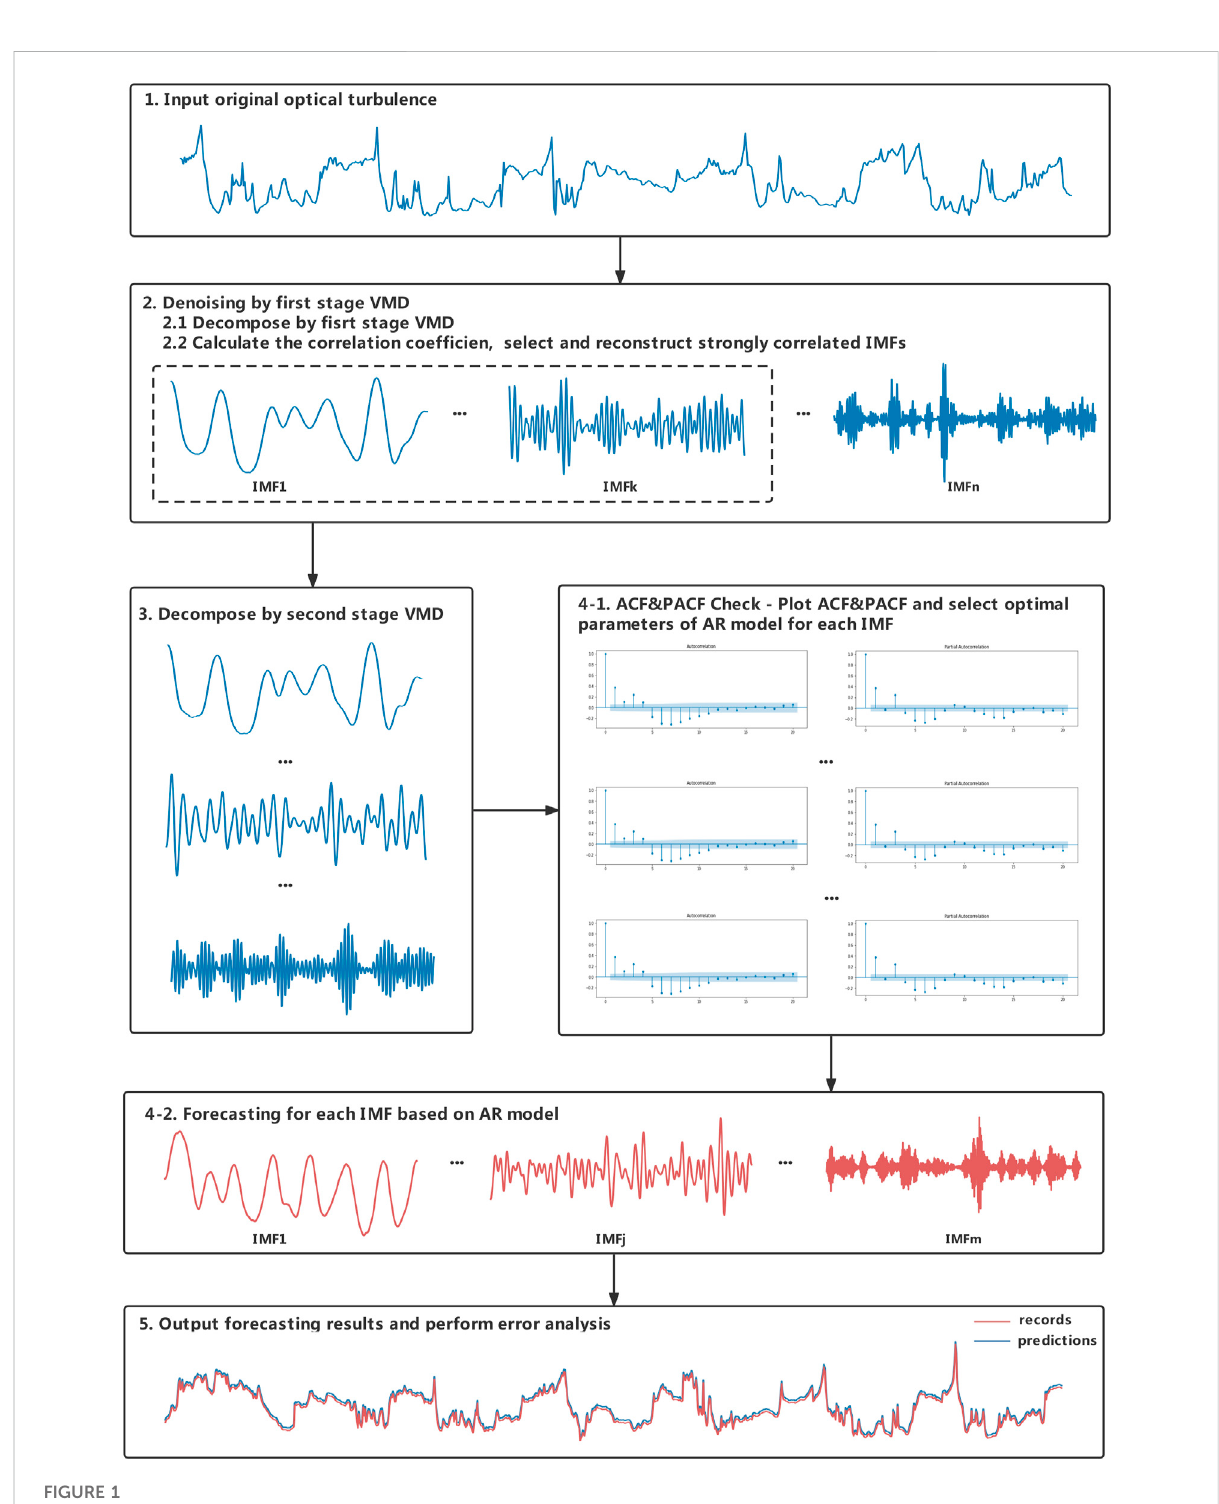
FIGURE 1 Schematic diagram of TsVMD-AR